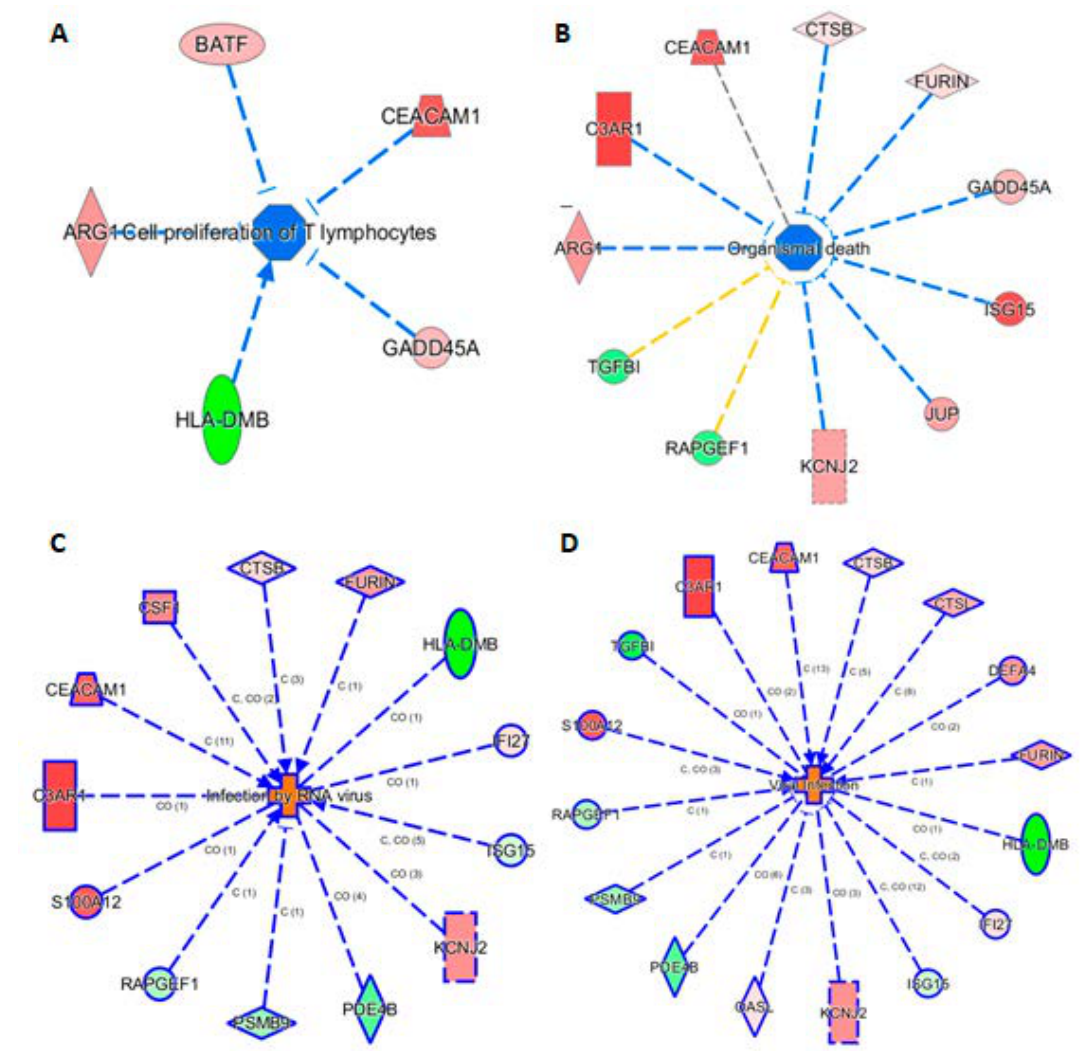
Figure 5. Subnetworks for selected InSep biomarkers connecting to phenotypes of interest. Disease-related phenotypes are ( A ) cell proliferation of T lymphocytes, ( B ) organismal death, ( C ) infection by RNA virus, and ( D ) viral infection.